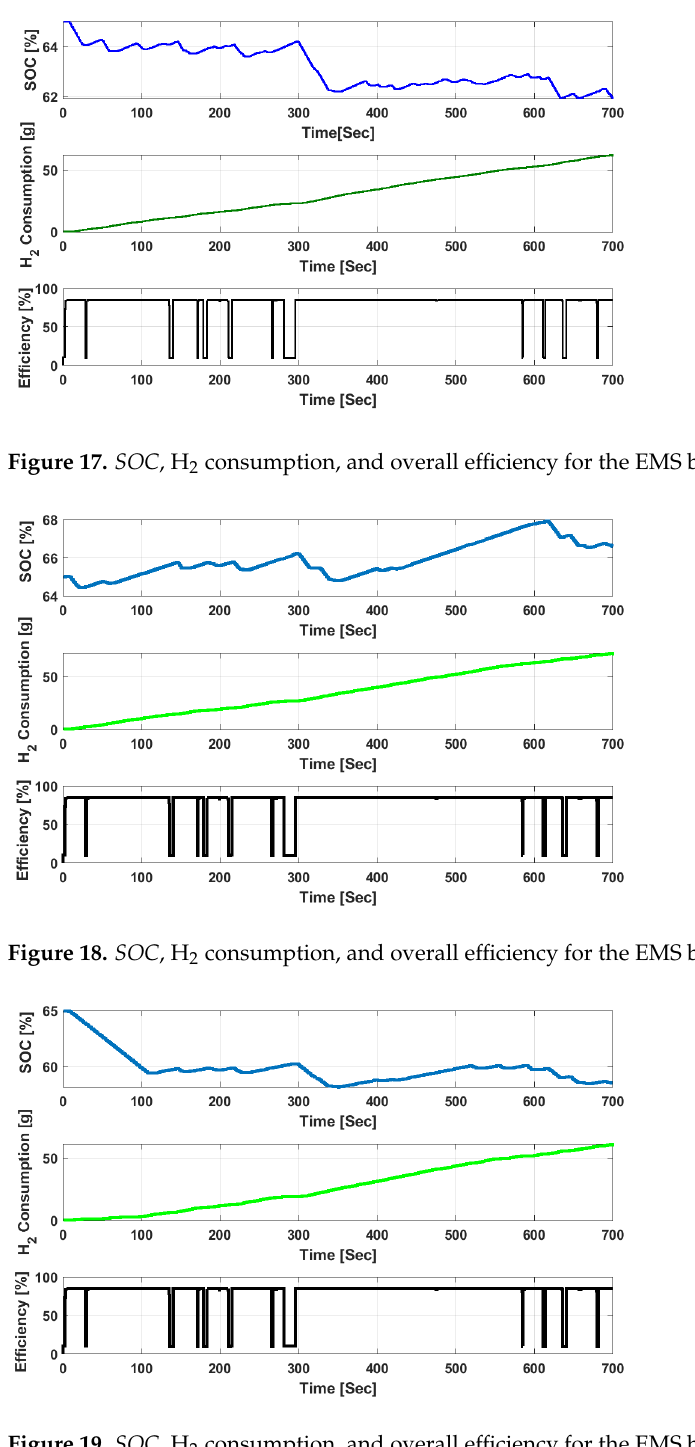
Figure 19. SOC , H 2 consumption, and overall efficiency for the EMS based on the